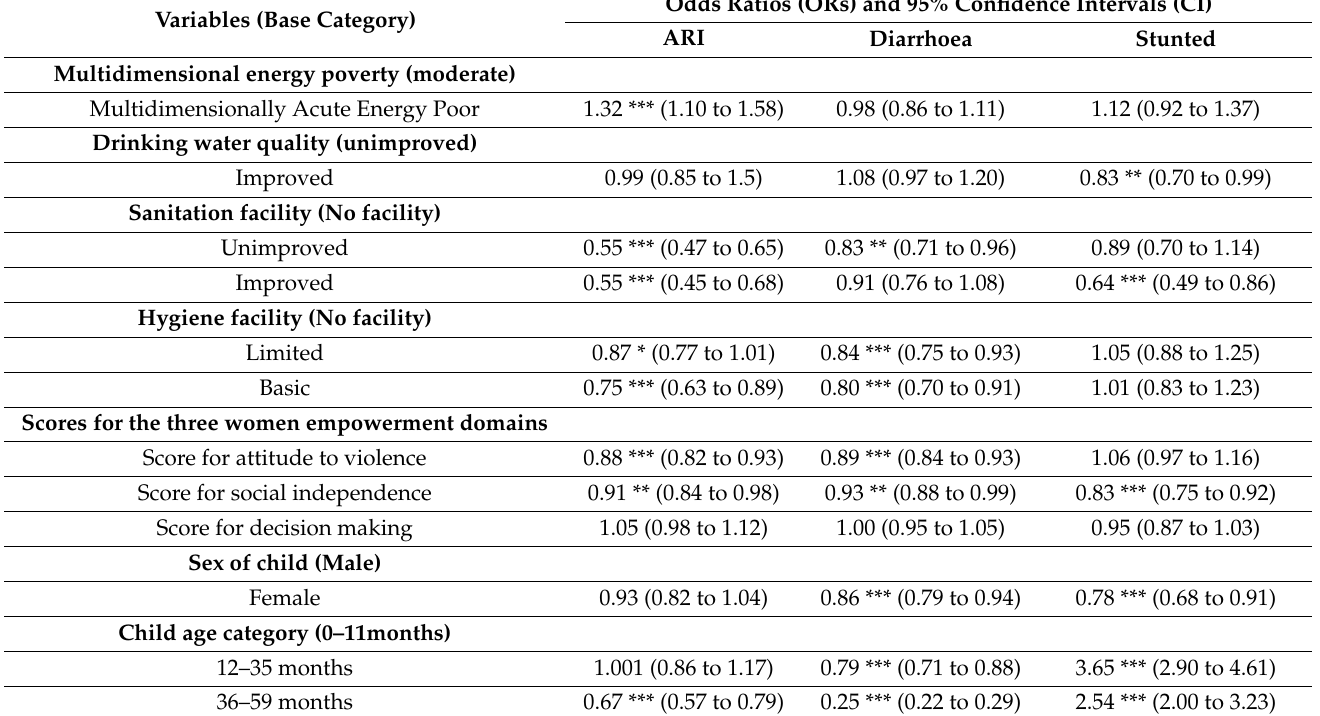
Table 5. The odds ratios and confidence intervals with significance level for the studied covariates from the logistic regression models for ARI, diarrhoea, and